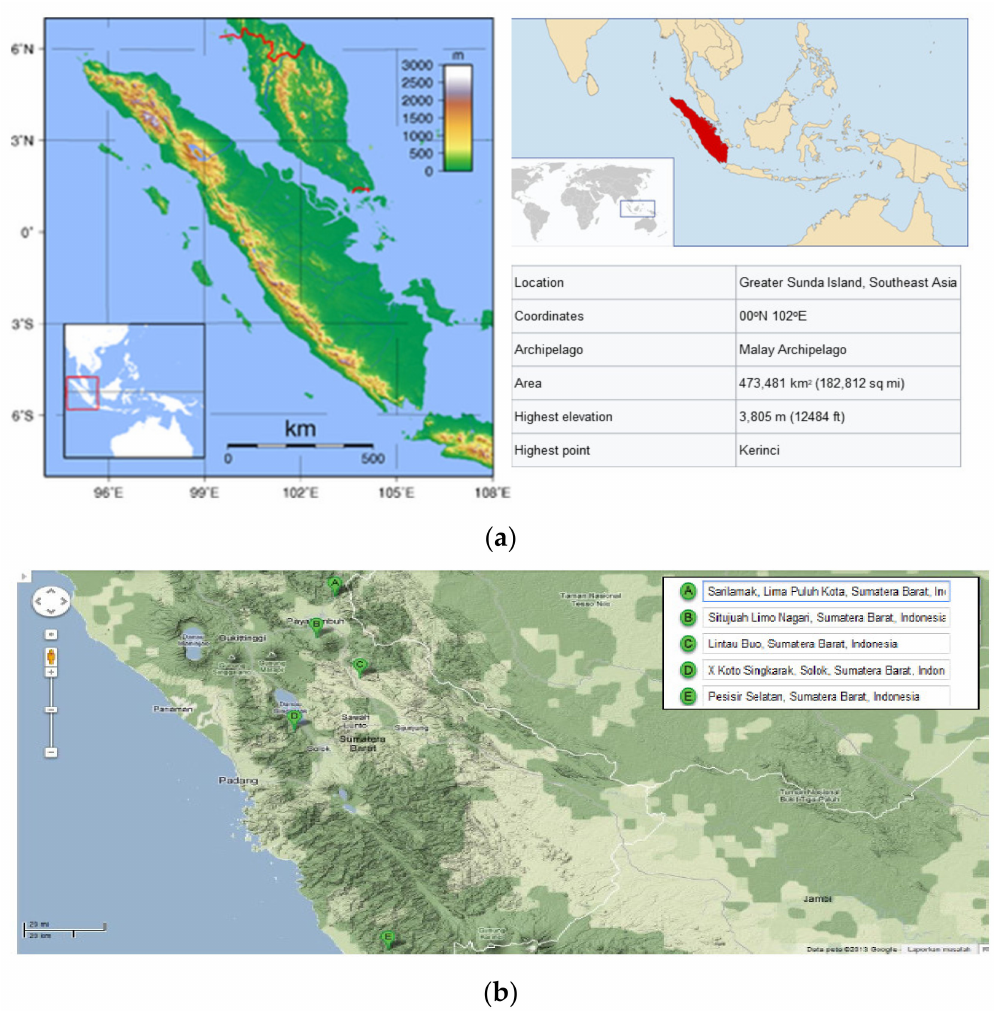
Figure 1. ( a ) Napa soil distribution in Sumatera Island. Topography of West Sumatera, ( b ) and map of West Sumatera province which contains the largest amount of Napa soil